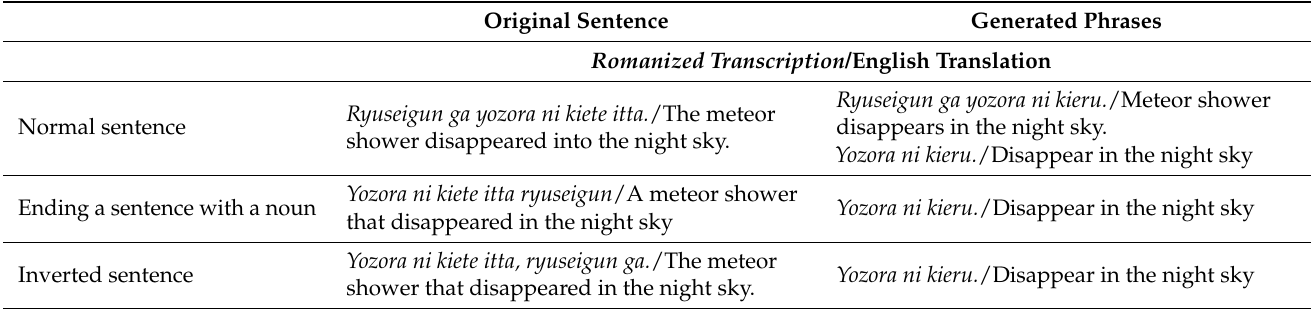
Table 5. Effect of inversion and ending a sentence with a noun in generated phrases. Original